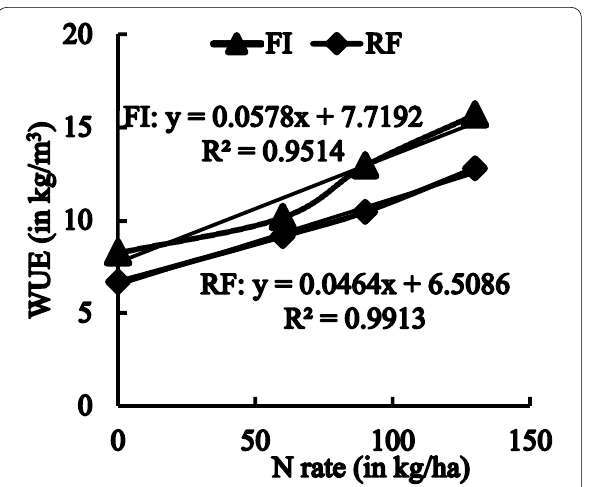
Fig. 7 Relationship between WUE and N-rates under different irrigation